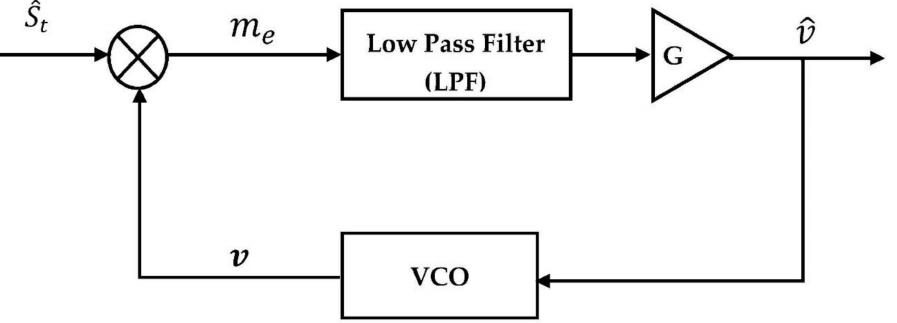
Figure 11. The structure of signal demodulation using